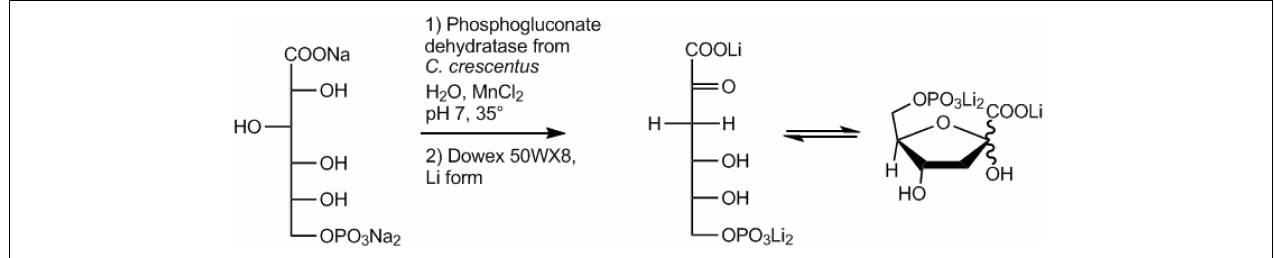
FIGURE 1 | Schematic illustration of the KDPG production scheme developed in this work involving the 6-phosphogluconate dehydratase from C . crescentus